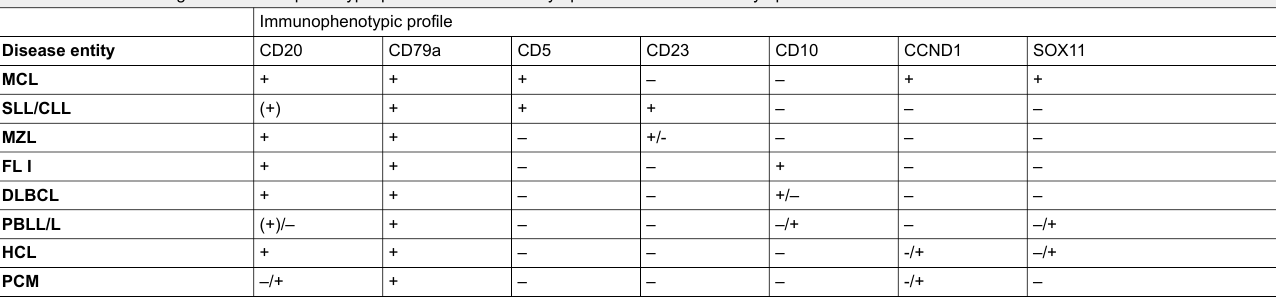
Table 1: Differential diagnostic immunophenotypic profiles of mantle cell lymphoma and other B-cell lymphomas. Immunophenotypic